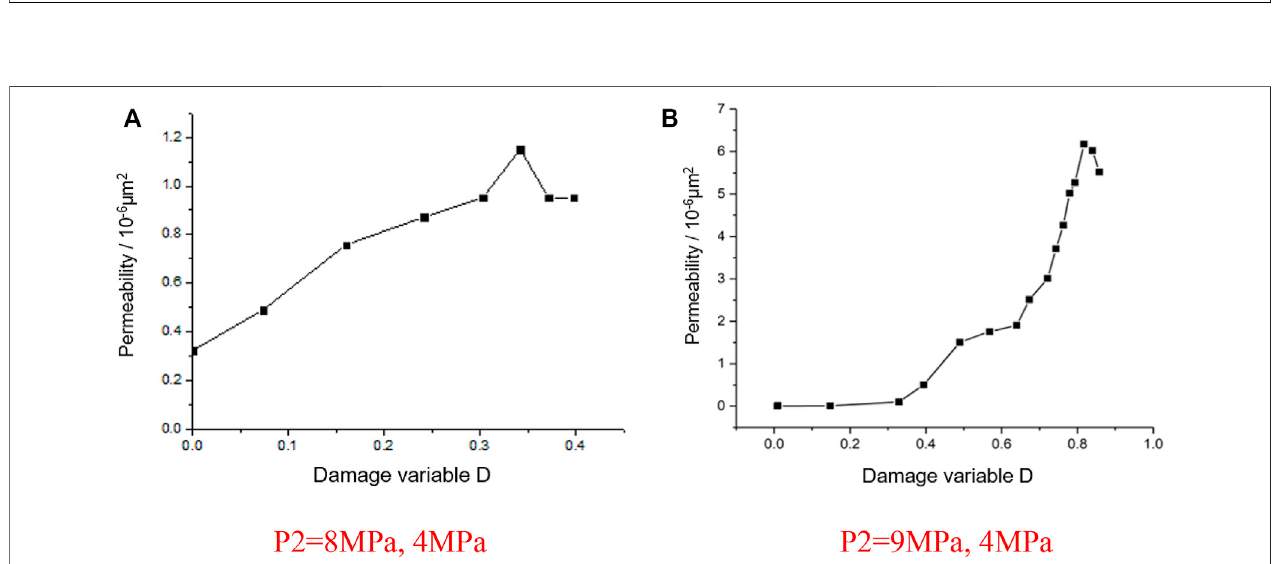
FIGURE 12 | Damage variable-permeability curve. (A) P2 = 8MPa, 4MPa. (B) P2 = 9MPa, 4MPa.